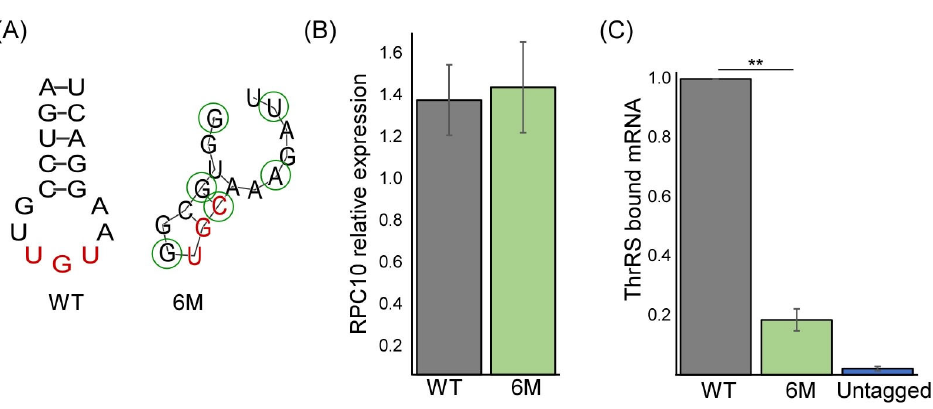
Figure 3. RPC10 ASL ‐ like structure is important for binding. ( A ) Structure prediction of the normal (WT) ASL ‐ mimic in RPC10 and the predicted the lowest binding efficiency mimic (6M). Green cir ‐ cles indicate mutated positions in 6M. ( B ) Steady ‐ state levels of wildtype (WT) and mutant (6M) RPC10 mRNA were quantified by RT ‐ qPCR analysis from three independent biological repeats, each with three technical repeats, normalized to ACT1 mRNA levels. ( C ) ThrRS ‐ GFP expressing yeast strains, endogenously co ‐ expressing either WT or 6M RPC10 mRNA and an untagged control,